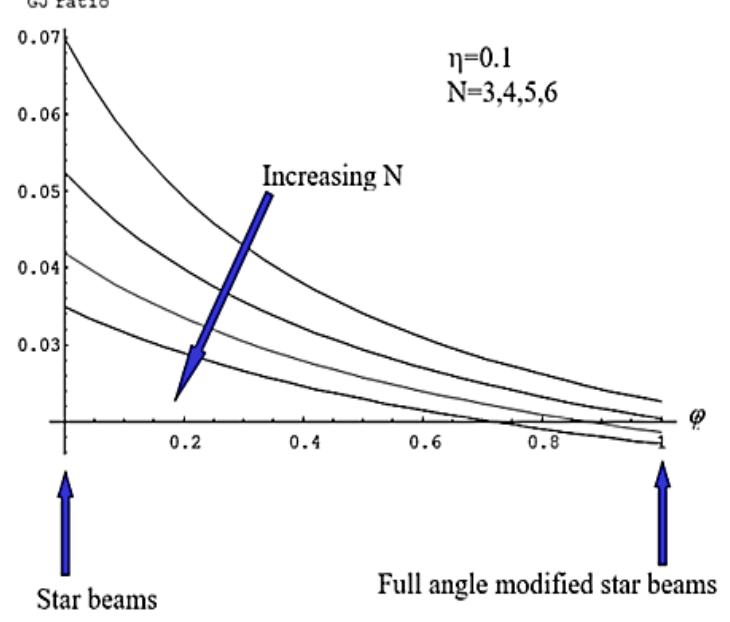
Figure 2. Variation of torsional rigidity ratio